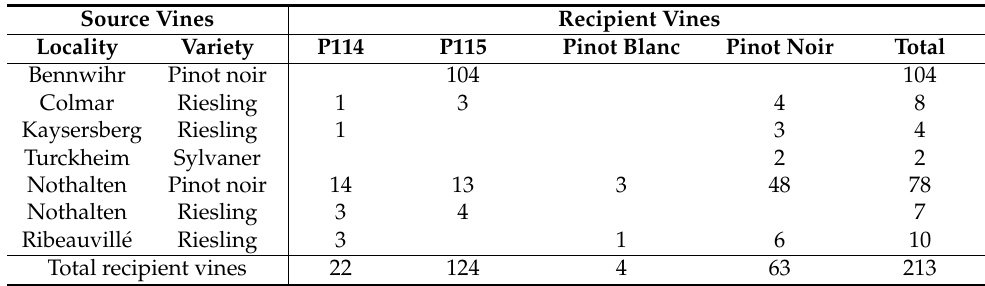
Table 2. Numbers of recipient vines used in infectivity experiments, according to their cultivar and the origin of source